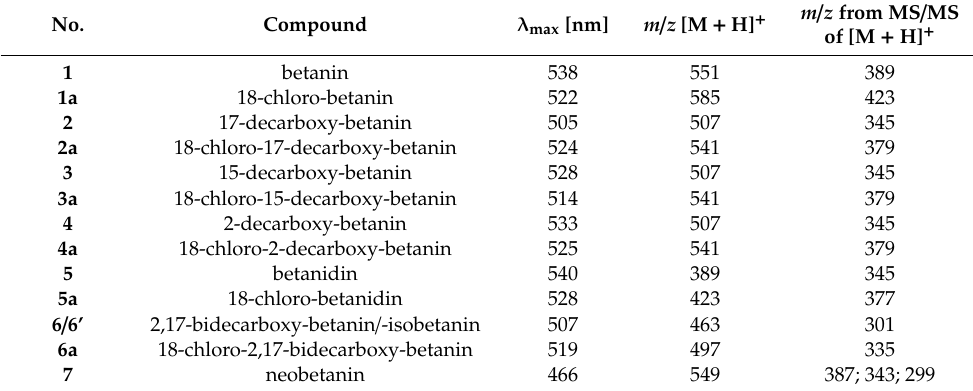
Table 1. Spectrophotometric and low-resolution mass spectrometric data of the studied betanin, decarboxylated betanins and their derivatives.